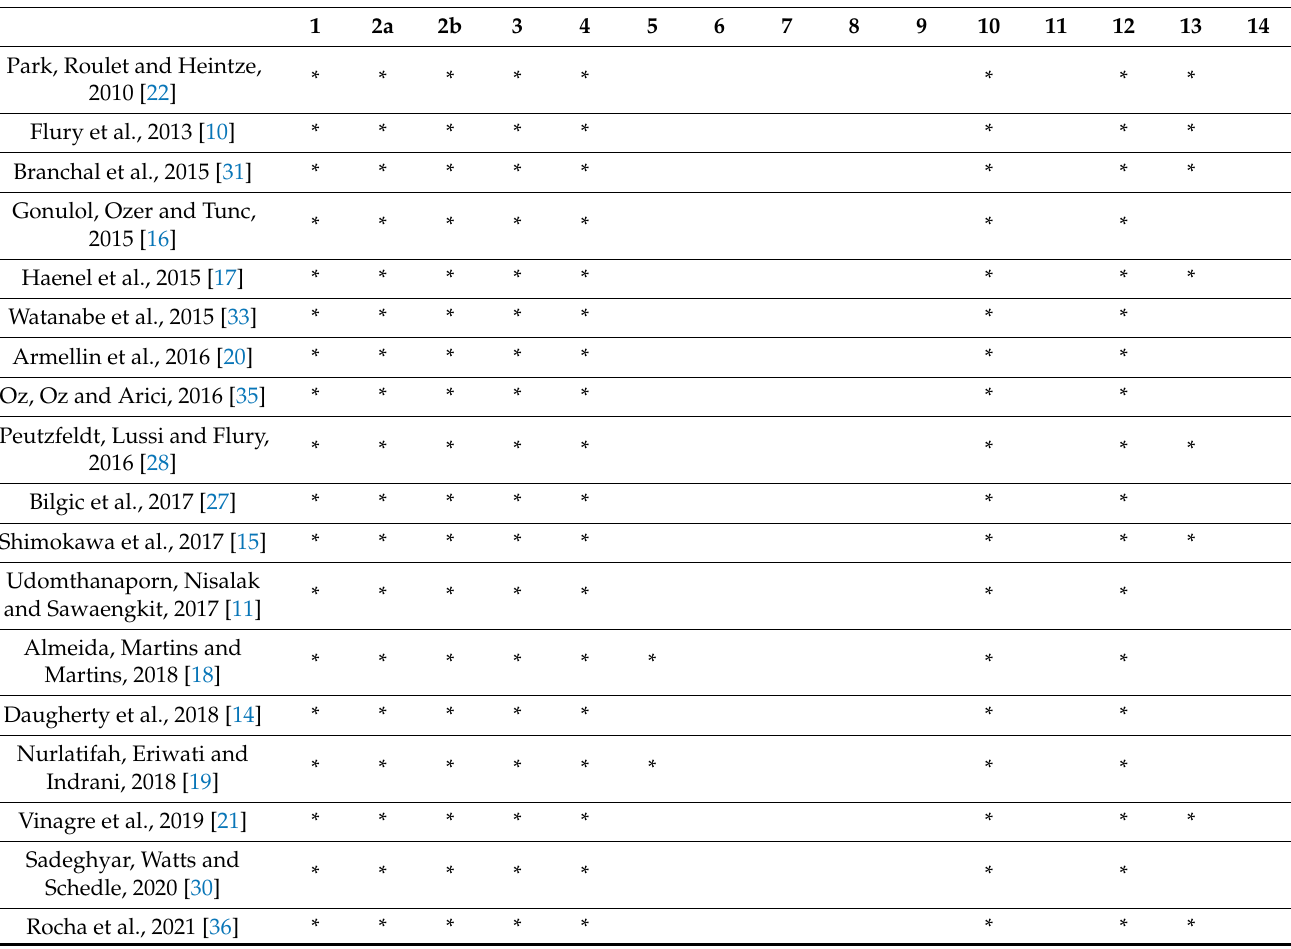
Table 3. Results of the assessment of in vitro studies by the use of the modified CONSORT checklist [25]. Cells marked with an asterisk “*” represent study fulfilment for the given quality assessment parameter. Cells left blank represent non-fulfilment.